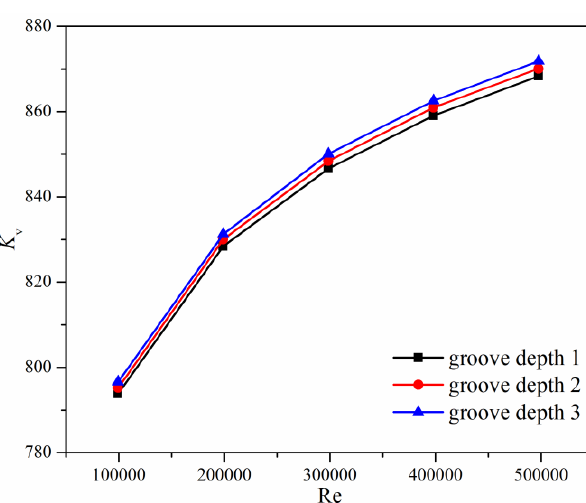
Figure 13. Flow coe ffi cients under di ff erent groove Figure 13. Flow coefficients under different groove depth.